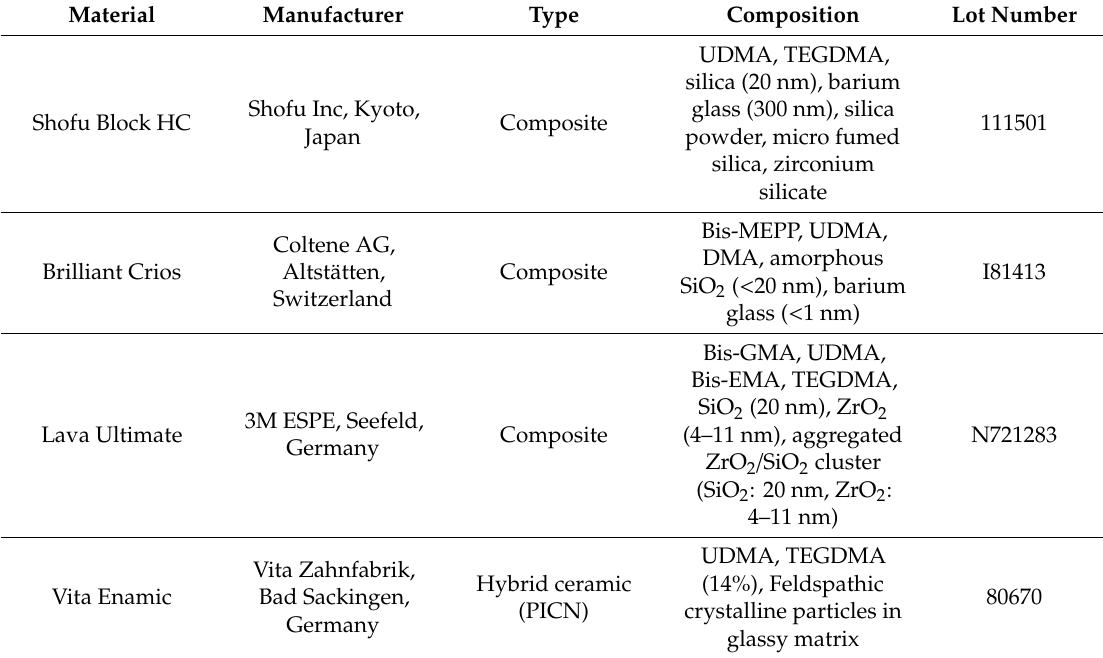
Table 1. The technical characteristics of the tested computer-aided design / computer-aided manufacture (CAD / CAM)